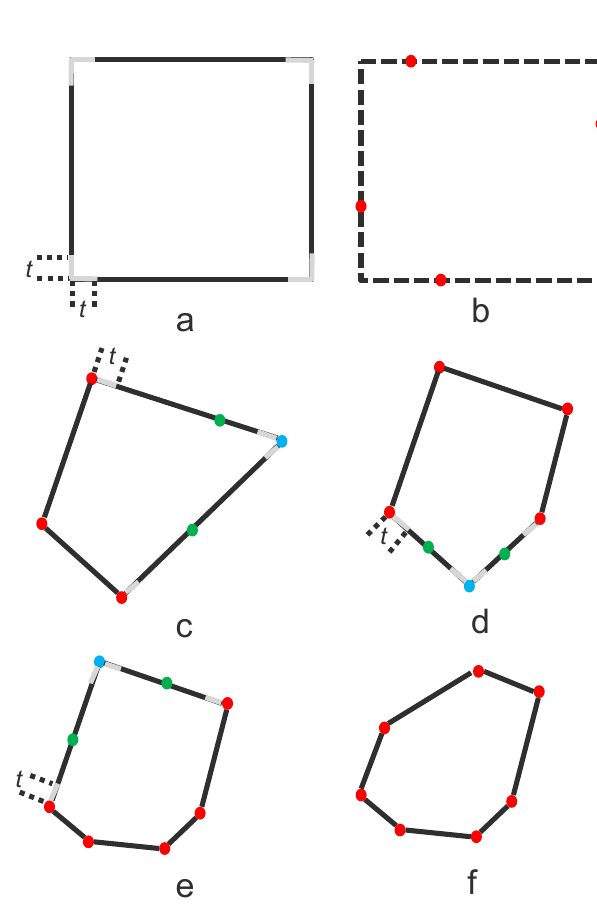
Figure 13: Random polygon generation